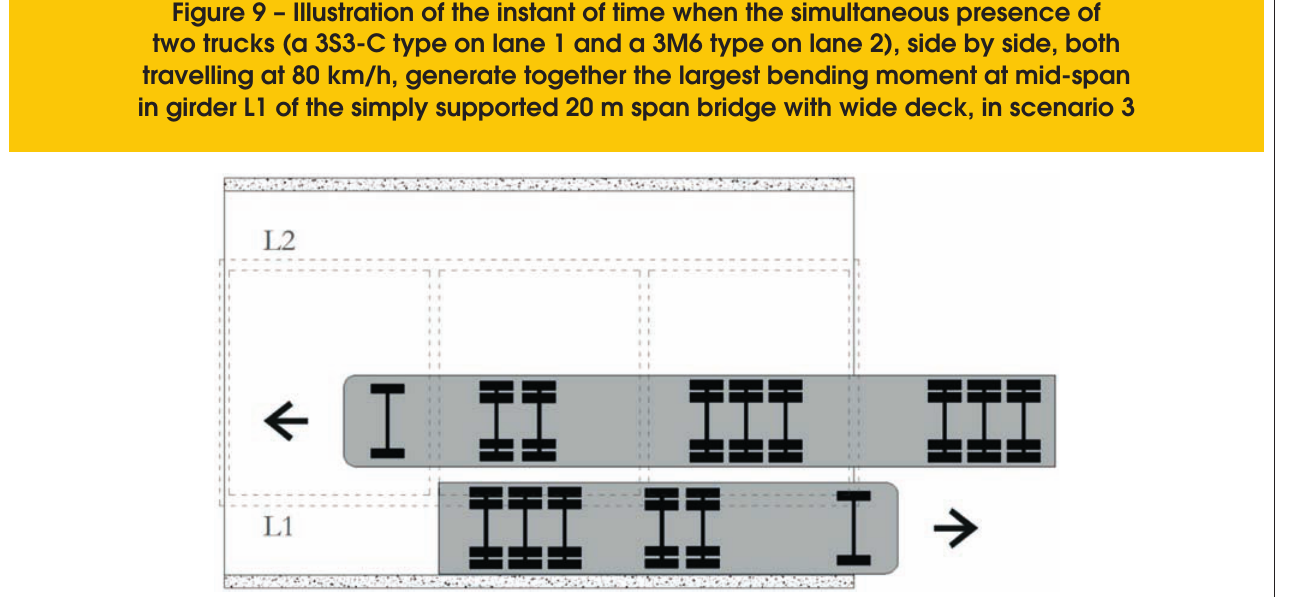
Figure 9 – Illustration of the instant of time when the simultaneous presence of two trucks (a 3S3-C type on lane 1 and a 3M6 type on lane 2), side by side, both travelling at 80 km/h, generate together the largest bending moment at mid-span in girder L1 of the simply supported 20 m span bridge with wide deck, in scenario